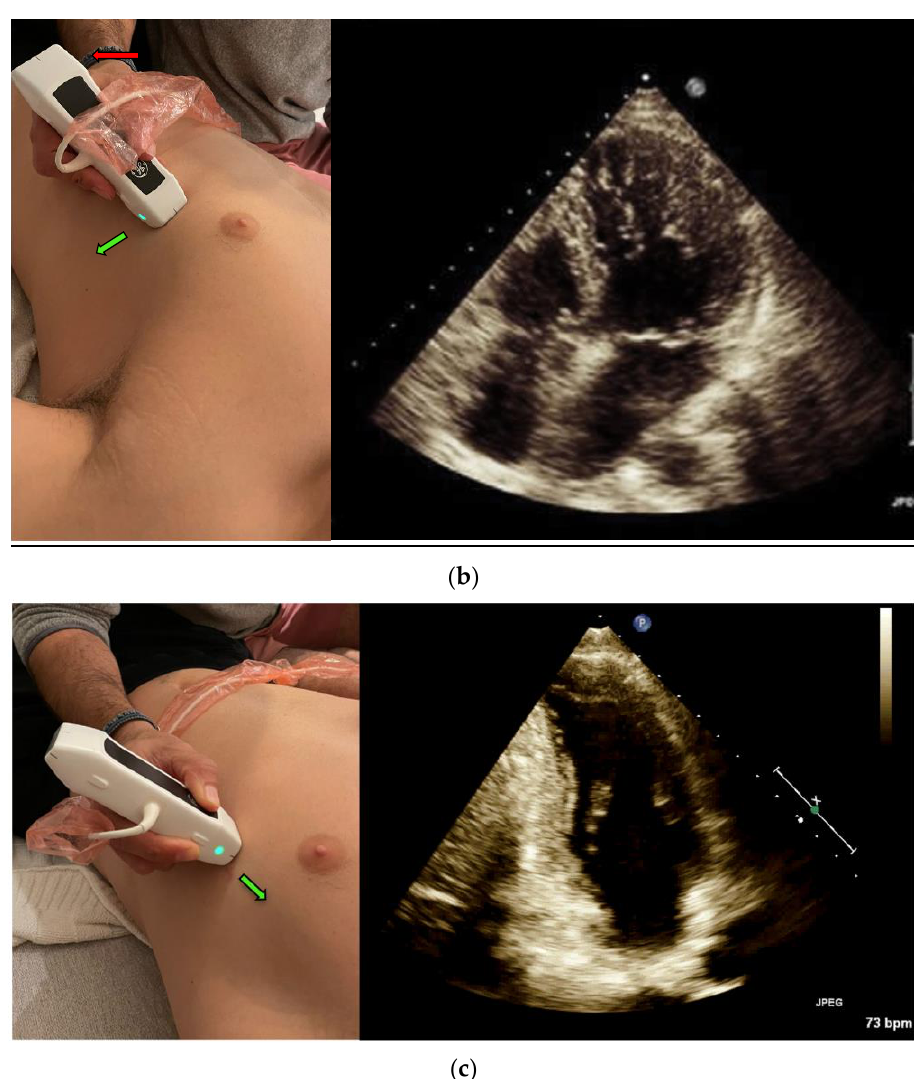
Figure 1. ( a ) Acquisition and anatomy of the Apical Four Chamber View. ( b ) Acquisition and anatomy of the Apical Five Chamber View (similar acquisition to Apical Four Chamber View, with a slight upward tilt of the probe). ( c ) Acquisition (probe point — green arrow) and anatomy of the Apical Two Chamber View.